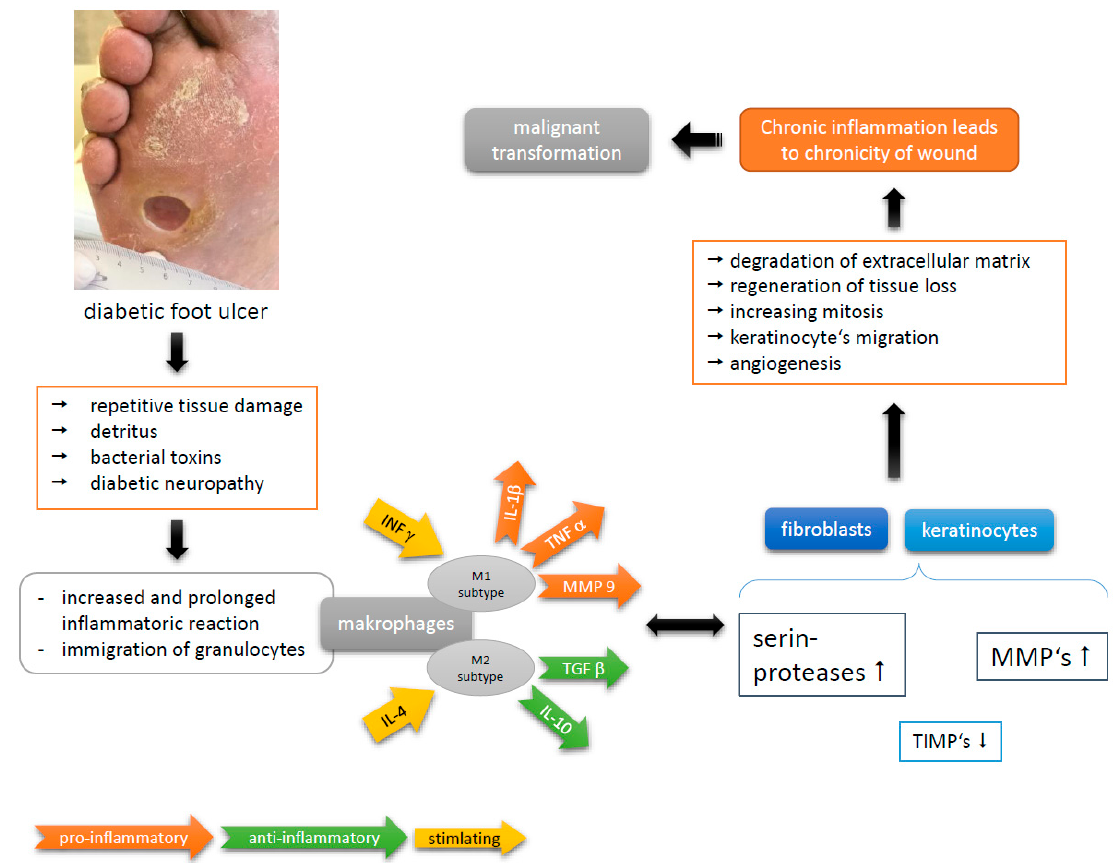
Figure 1. Pathophysiology of chronic wound in diabetic foot ulcers (DFU) (modified and based on [4,5]).